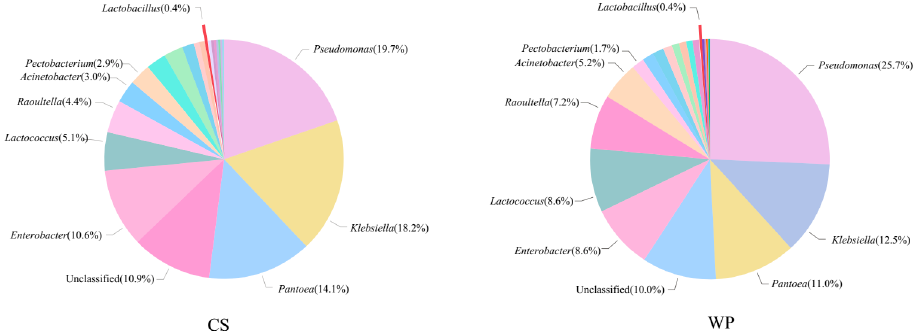
Figure 4. Bacterial communities at genus level of sweet corn stover (CS) and whole plant (WP) before ensiling. Top 9 genera and Lactobacillus are labeled and their relative abundance is shown in brackets.